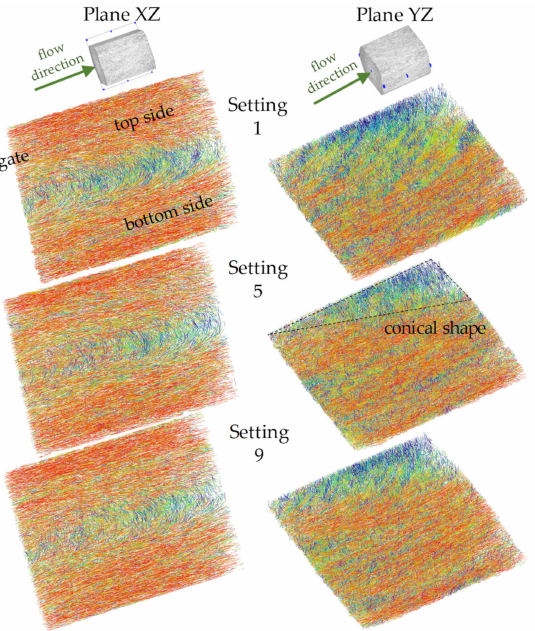
Figure 6. Qualitative comparison of fiber orientations from µ CT analysis in the XZ- and YZ-plane of region 1 after specimen manufacturing with setting 1, 5, and